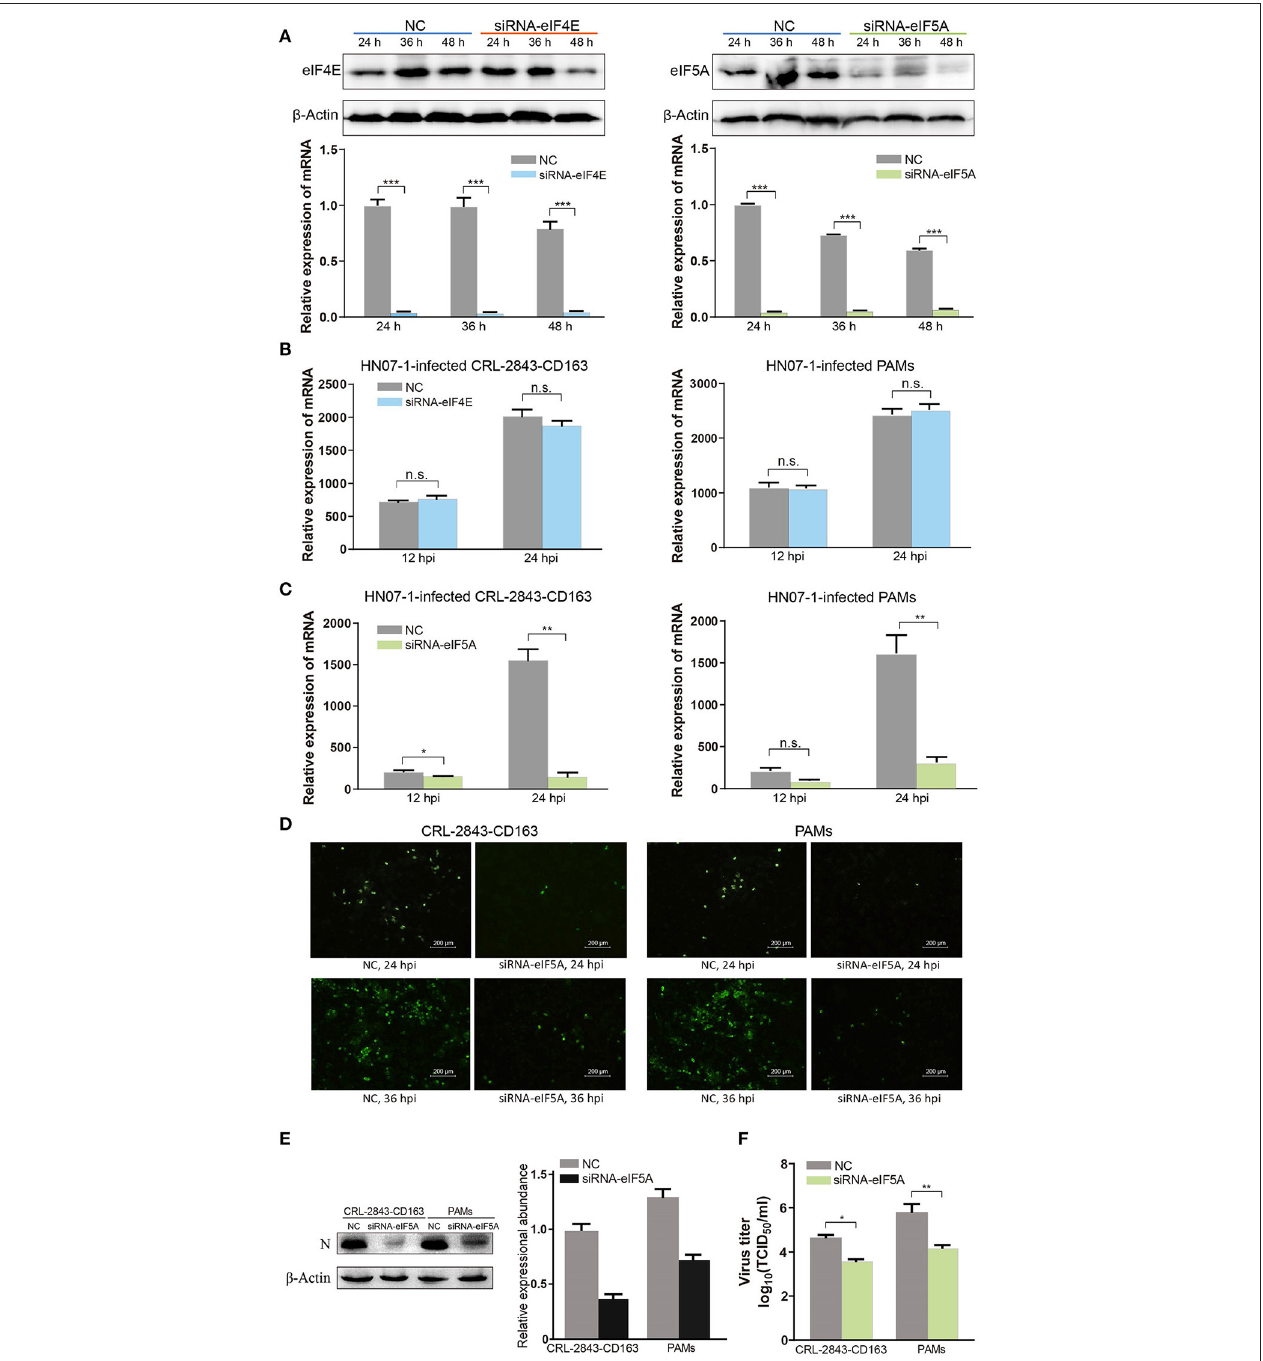
FIGURE 7 | EIF5A is important for PRRSV infection in vitro . (A) SiRNA-eIF4E and siRNA-eIF5A were transfected into CRL-2843-CD163 cells for 24, 36, or 48h, with NC transfected as the control. The knockdown effect was validated by RT-PCR and WB. (B) The eIF4E knockdown CRL-2843-CD163 cells or PAMs were inoculated with HP-PRRSV HN07-1 (MOI = 0.1) and harvested at 12 and 24 hpi for RT-PCR analysis. (C) The eIF5A knockdown CRL-2843-CD163 cells or PAMs were inoculated with HP-PRRSV HN07-1 (MOI = 0.1) and harvested at 12 and 24 hpi for RT-PCR analysis. (D) HP-PRRSV HN07-1 (MOI = 0.1) was used to inoculate eIF5A knockdown CRL-2843-CD163 cells or PAMs and harvested at 24 hpi for IFA analysis with anti-PRRSV N protein antibody. (E) HP-PRRSV HN07-1 (MOI = 0.1) was used to inoculate eIF5A knockdown CRL-2843-CD163 cells or PAMs then cells were harvested at 24 hpi for WB analysis with anti-PRRSV N protein antibody. (F) HP-PRRSV HN07-1 (MOI = 0.1) was used to inoculate eIF5A knockdown CRL-2843-CD163 cells or PAMs then cells were harvested at 48 hpi. Viral yields were determined based on TCID 50 values in MARC-145 cells. Each experiment was carried out three times independently and yielded consistent findings. * P < 0.05; ** P < 0.01; *** P < 0.001; ns, not significant.